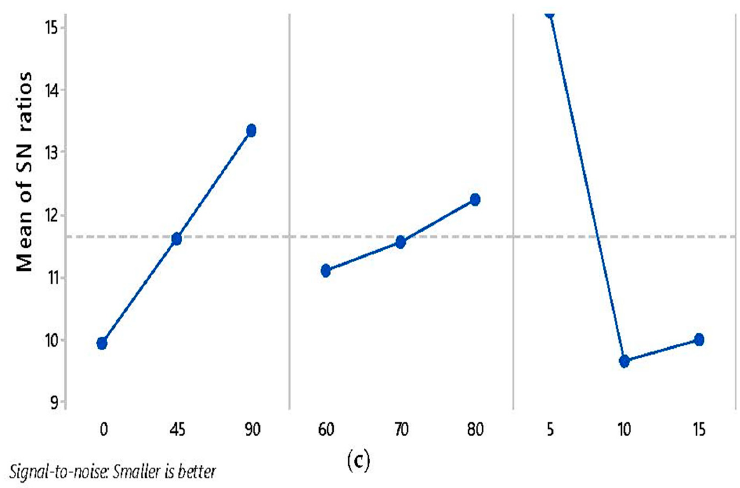
Figure 4. Main-e ff ects plot for S / N-ratio of ( a ) Percent-variation in Surface-roughness ( b ) tensile Figure 4. Main-effects plot for S/N-ratio of ( a ) Percent-variation in Surface-roughness ( b ) tensile Strength ( c ) Percentage change in Strength ( c ) Percentage change in weight.